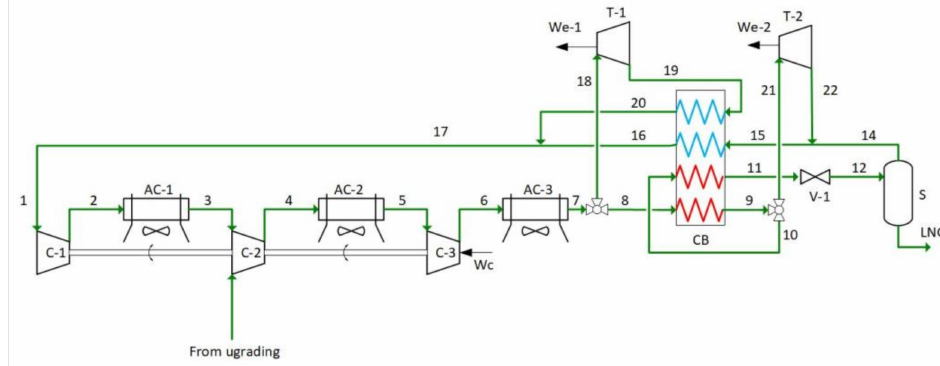
Figure 2. Kapitza process with double expander (DE).